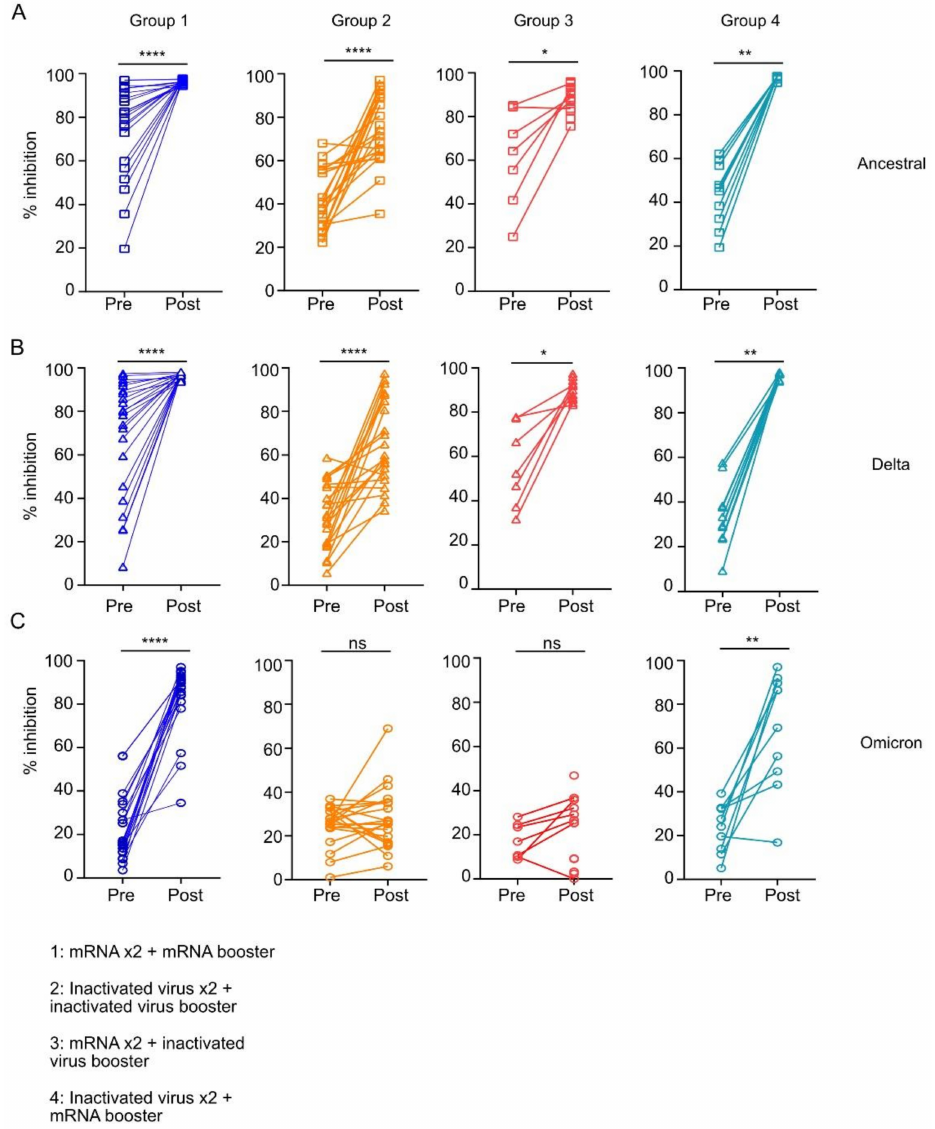
Figure 2. Neutralizing activity of antibodies against RBD of the original strain, Delta and Omicron variant of SARS-CoV-2 following mRNA or inactivated virus vaccine booster in individuals previously immunized with two doses of mRNA or inactivated virus vaccine. Comparison of percentage inhibition of antibody binding to RBD of spike protein by ( A ) original strain ( B ) Delta variant or ( C ) Omicron variant, in plasma samples obtained 1–7 days before booster vaccination and 28 ± 5 days post booster vaccination from individuals receiving (1) three doses of mRNA vaccines; (2) three doses of inactivated virus vaccines; (3) two doses of mRNA vaccines followed by a booster shot with an inactivated virus vaccine; and (4) two doses of inactivated virus vaccines followed by a booster shot with mRNA vaccine. Two symbols connected by a line represent repeated samples from a unique individual pre and post-booster vaccination. Only 7 out of 13 individuals provided pre-booster blood samples in Group 3. AU = Arbitrary Units. Statistical tests: Wilcoxon matched-pairs signed-rank tests whereby * p < 0.05, ** p < 0.01, **** p < 0.0001 and ns = not